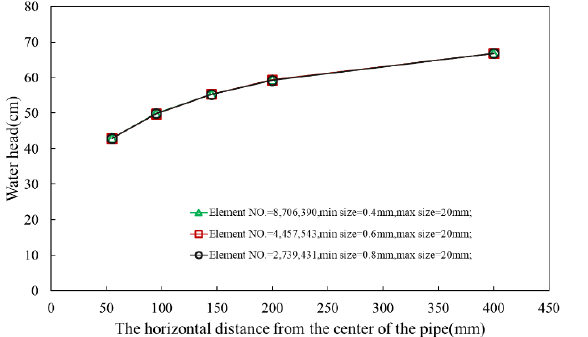
Figure 7. Plot of the water head horizontally along the pipe for different mesh sizes.